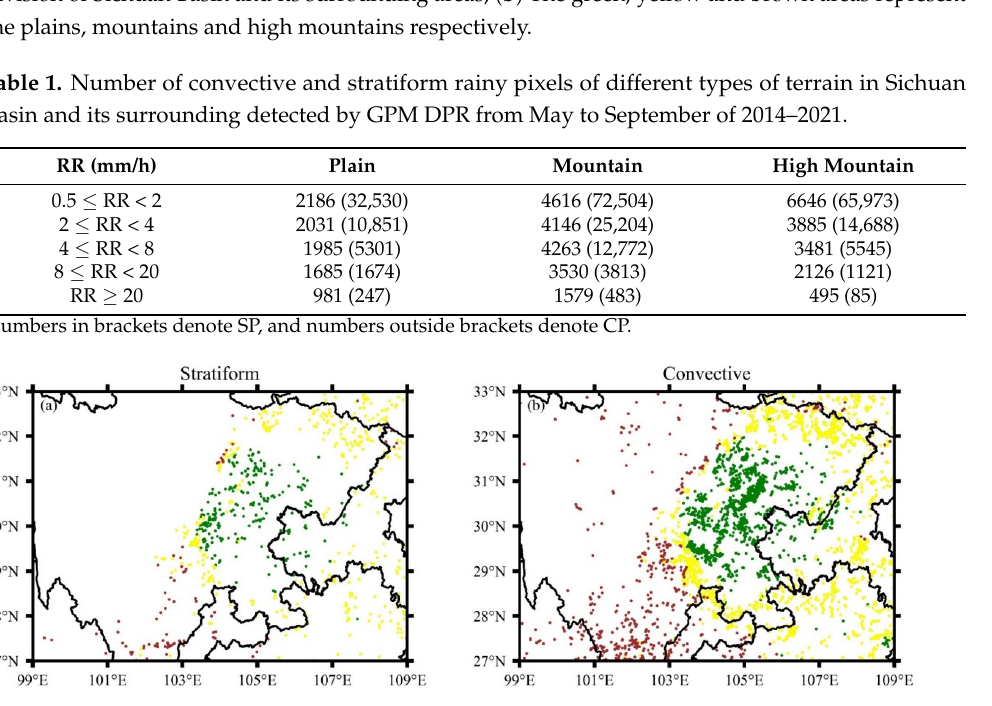
Figure 2. The spatial distribution of heavy stratiform ( a ) and convective ( b ) rainy pixels. The heavy precipitation occurs over plains (green dots), mountains (yellow dots) and high mountains (brown dots).